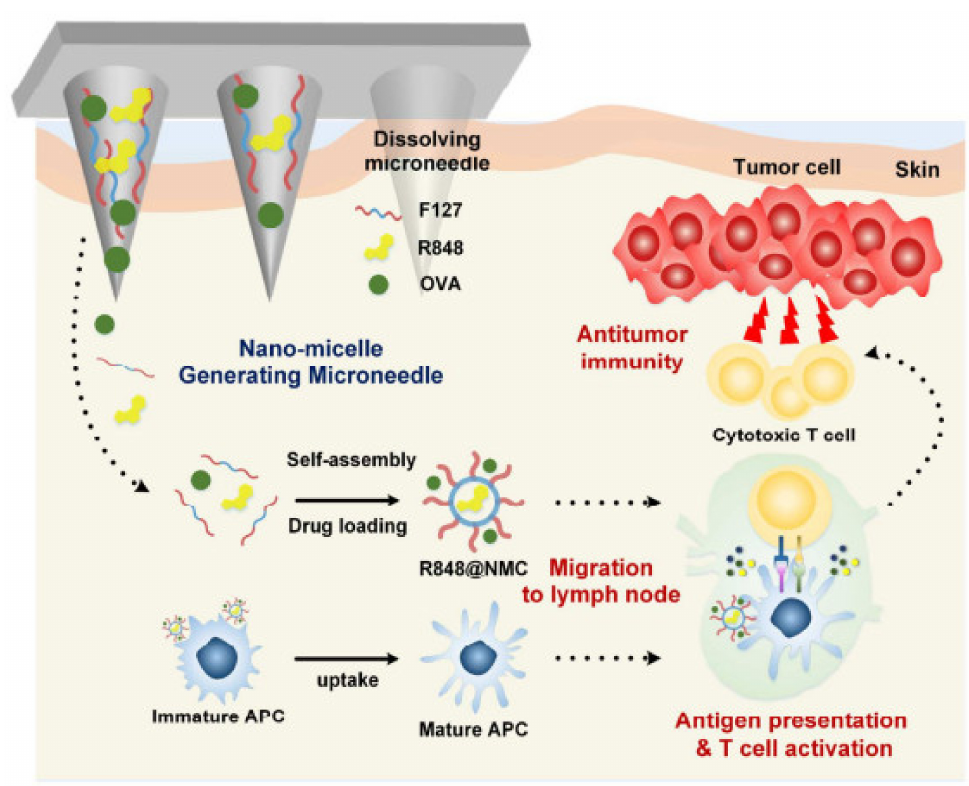
Figure 17. Dissolving MNs loaded with vaccines and hydrophobic adjuvants for improved cancer therapy [244]. (Adapted with permission from Ref. [244]. Copyright 2018 American Chemical